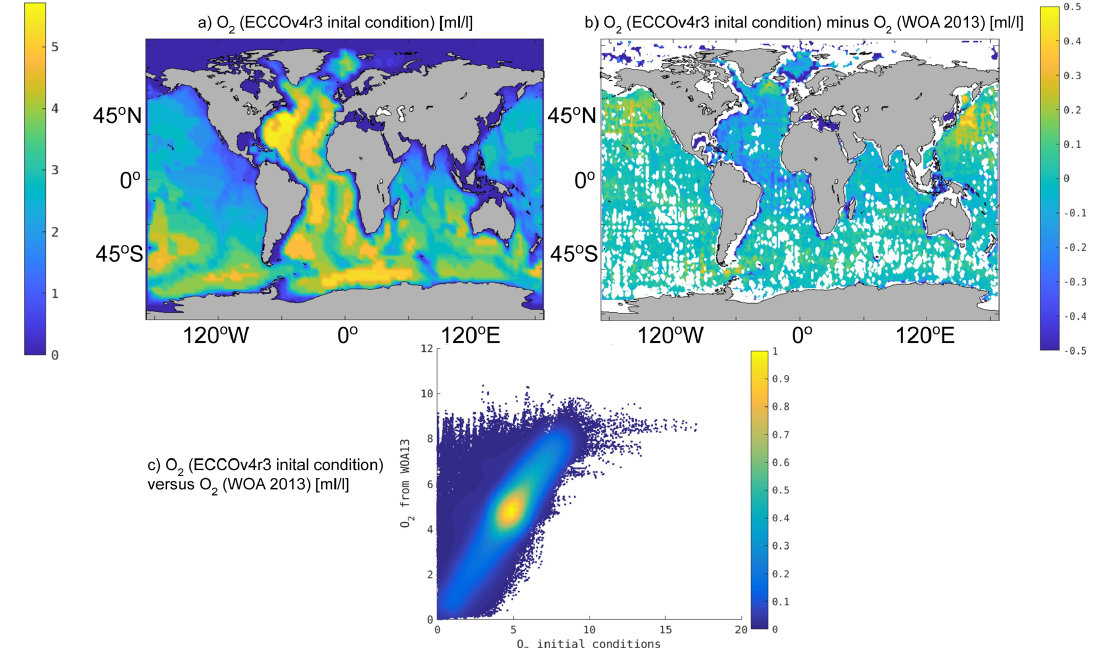
Figure 3. Shown are (a) the depth-averaged oxygen concentrations’ initial conditions in ECCO (units in mLL − 1 ), (b) the depth-averaged oxygen concentrations’ initial conditions in ECCO minus the depth-averaged observational climatologies from the World Ocean Atlas (2013) (units in mLL − 1 ) at locations where observations were sampled, and (c) the pointwise comparisons between the oxygen concentrations’ initial conditions and the observational climatologies from the World Ocean Atlas (2013) (units in mLL − 1 ), which are used for the ECCO adjoint sensitivity experiments in the model’s cost function. White areas in panel (b) in the ocean indicate insufficient data to calculate a depth